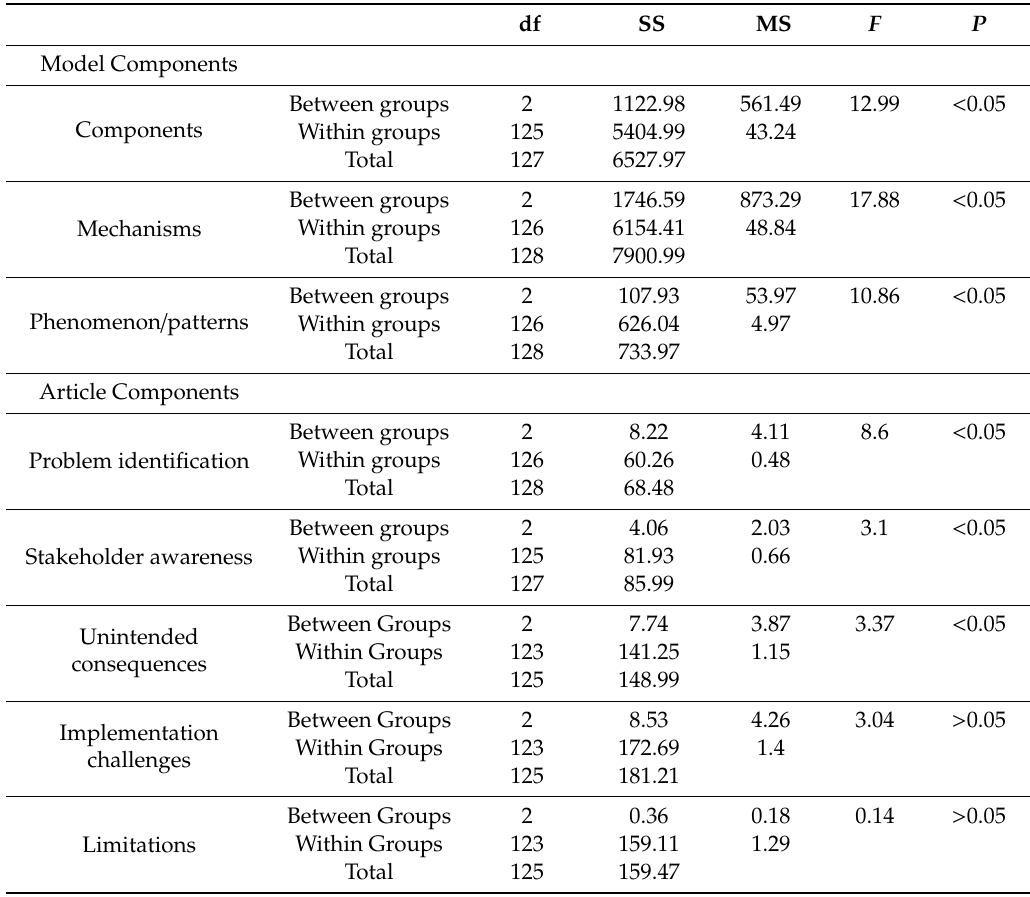
Table A2. Model and article rubric components ANOVA analysis.